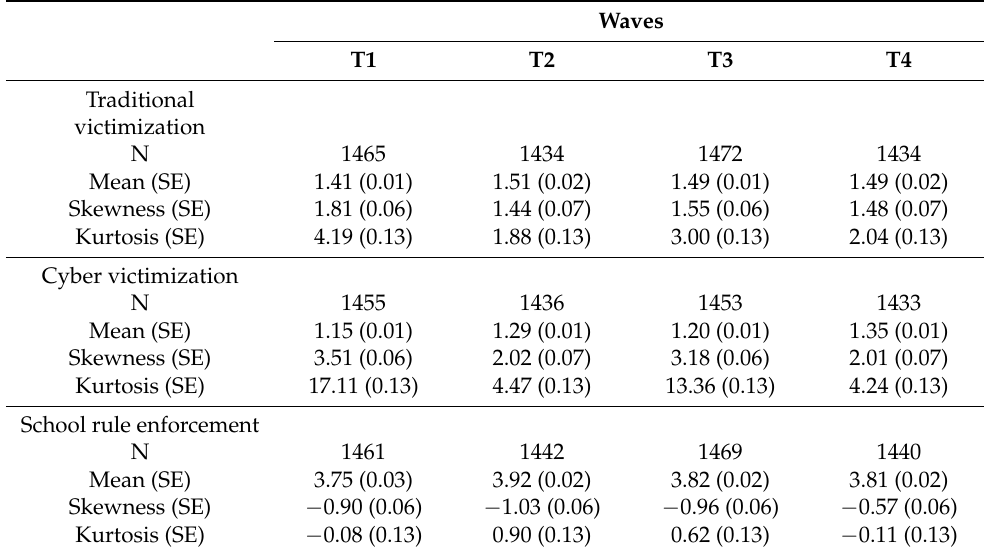
Table 1. Descriptive Statistics: Longitudinal assessment of traditional victimization, cyber victimiza- tion and perceived school rule enforcement. Waves T1 T2 T3 T4 Traditional